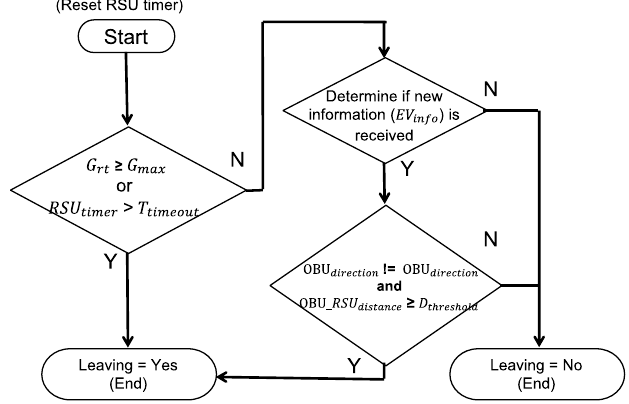
Figure 12. The algorithm of determining if OBU leaves the intersection.